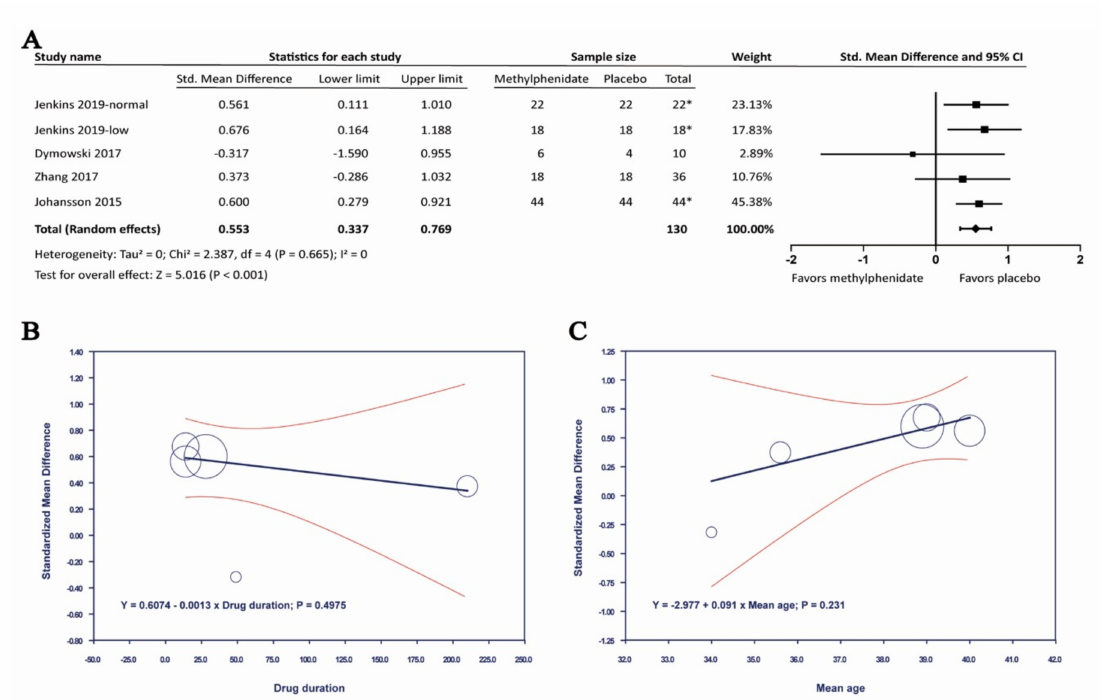
Figure 7. The e ff ects of methylphenidate in heart rate. ( A ) Forrest plot of the e ff ects of methylphenidate in heart rate, ( B ) Meta-regression analysis of heterogeneity with drug duration, ( C ) Meta-regression analysis of heterogeneity with mean age. *: crossover